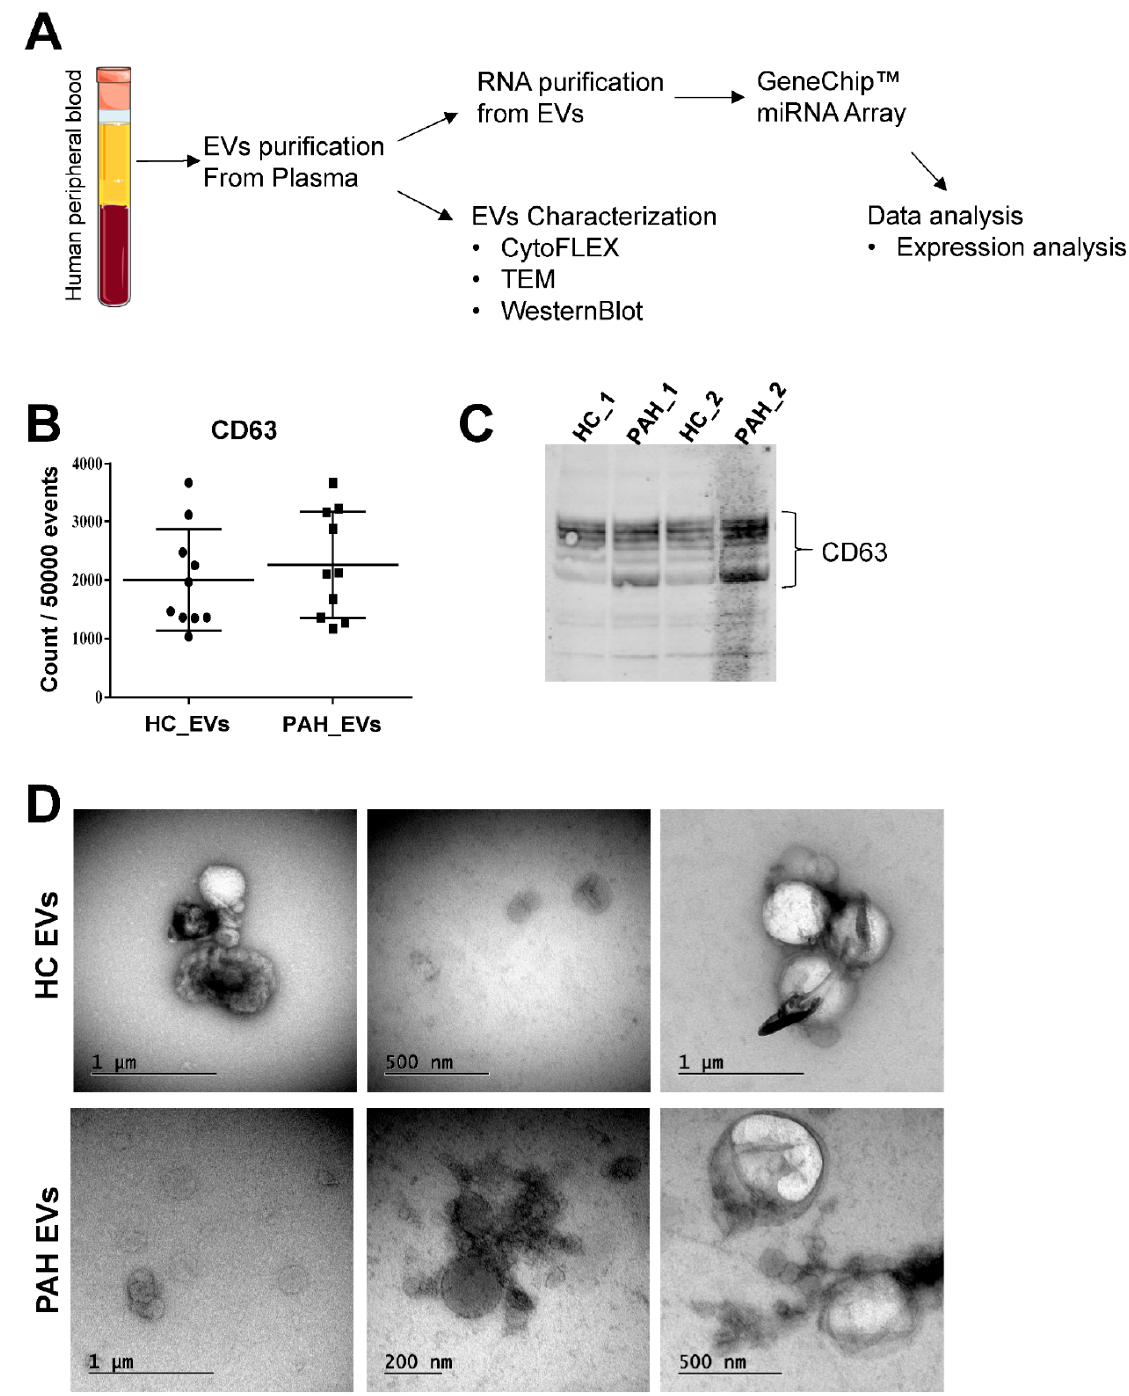
Figure 1. ( A ) Schematic representation of EV preparation and experimental workflow for miRNA profiling and EV characterization. ( B ) Purified EVs from healthy control (HC) and pulmonary arterial hypertension (PAH) patients were subjected to flow cytometry to detect expression levels of exosome-specific marker CD63. Results represent marker count/50,000 events and are given as mean ± S.E.M. ( n = 10 per group), comparing PAH versus HC. ( C ) Representative immunoblot of CD63 from EVs from HC and PAH patients. ( D ) Representative transmission electron micrographs of purified EVs from HC and PAH patients with uranyl acetate negative staining (scale bar 200–1000 nm) ( n = 5 per group; 10–20 images were taken per sample).